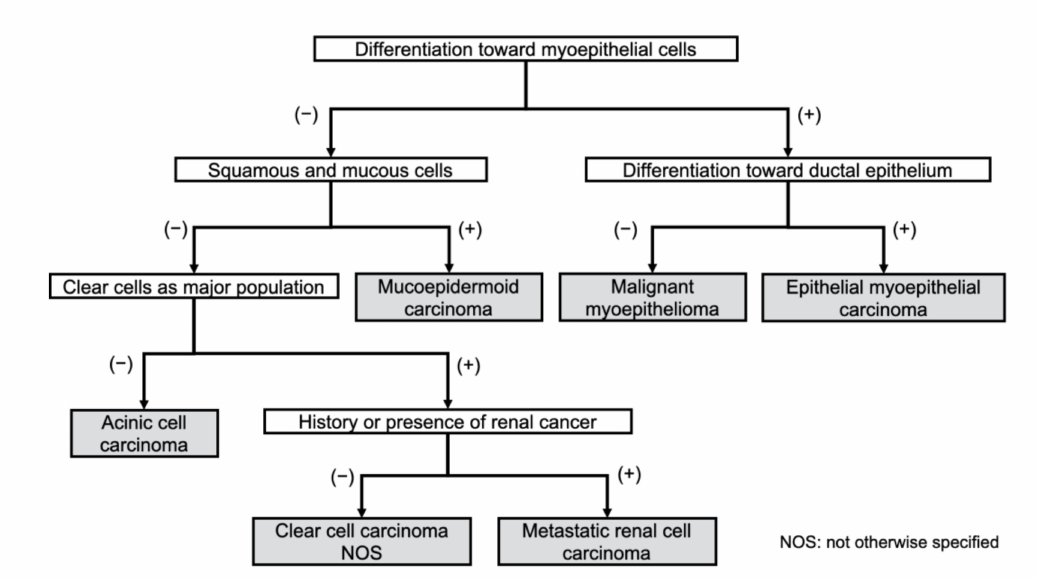
Figure 1. Diagnostic work chart of clear cell malignant tumors of the oral region.